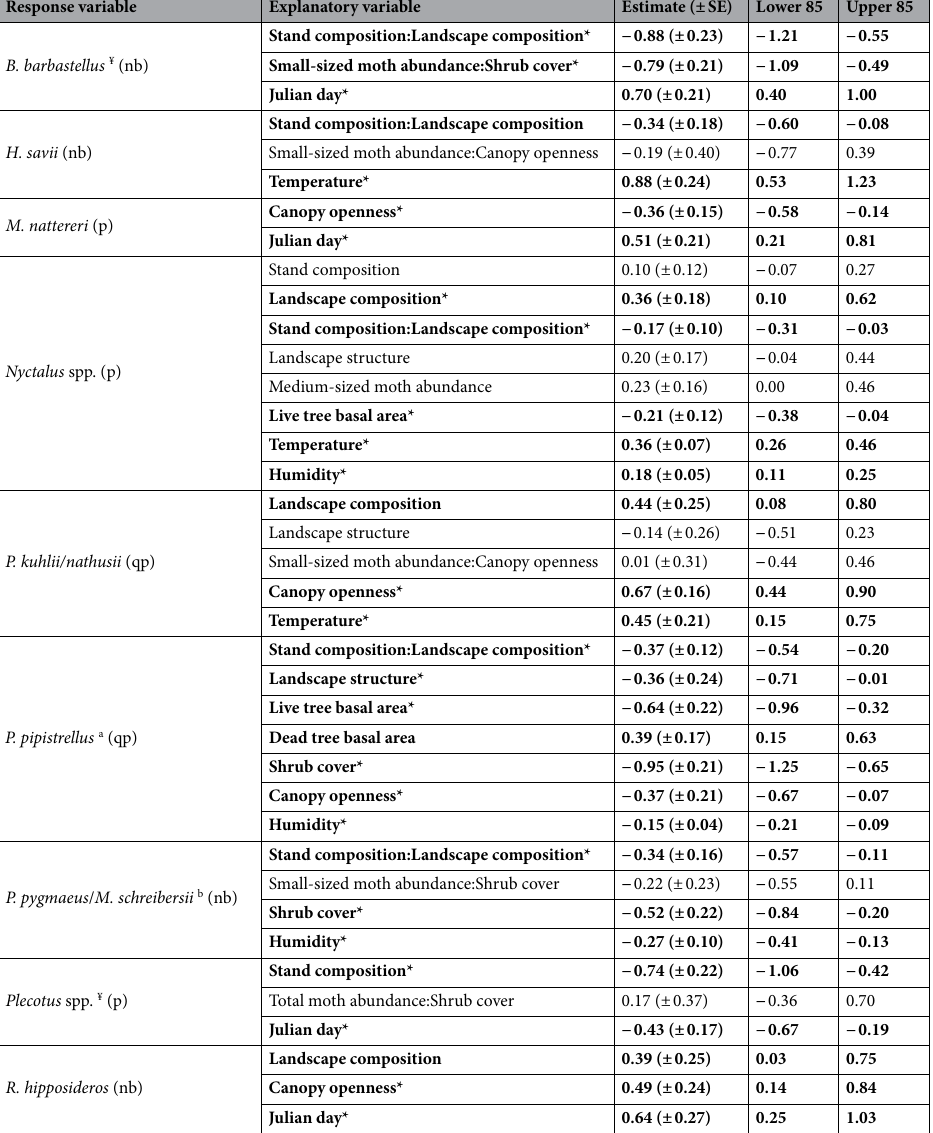
Table 1. Standardized, model-averaged parameter estimates with associated standards errors (SE) and 85% confidence intervals of the best GLMMs (Δ AICc < 2) relating the effects of forest composition, landscape structure, stand structure, moth abundance on bat activity. Results on bat activity are presented for the 50% maximum error risk tolerance applied to the identification of bat sequences and resulting bat activity (i.e. number of 1-min intervals with ≥ 1 bat sequences). Variables in bold represent influential variables for which 85% CI did not overlap zero. Stand composition corresponds to the percentage cover of deciduous trees within stand while landscape composition was inferred using the proportion of deciduous forests within the forested landscape area at 1 km radius scale. Family distribution of the GLMMs is given in brackets. a Only recordings from the Batlogger were considered, b One outlier was removed. Distribution family: p Poisson, qp quasi-Poisson, nb negative binomial. ¥ Moth-feeding specialist (Supplementary Table S6). *Influential variable showing consistent pattern between the two separate sets of bat activity (see Supplementary Table S3 regarding results on acoustic data with maximum error risk tolerance of